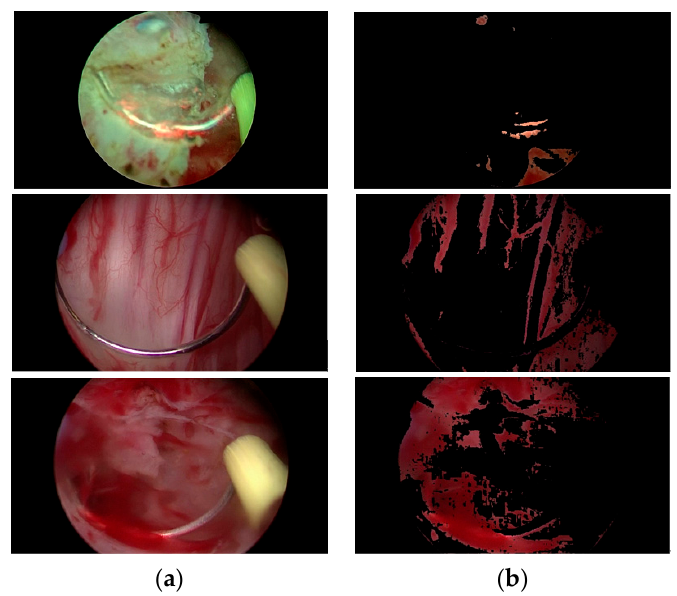
Figure 6. The example of the bleeding areas by the HSV color space. ( a ) Original image samples with the red and non-red lights. ( b ) The detection of the bleeding areas.